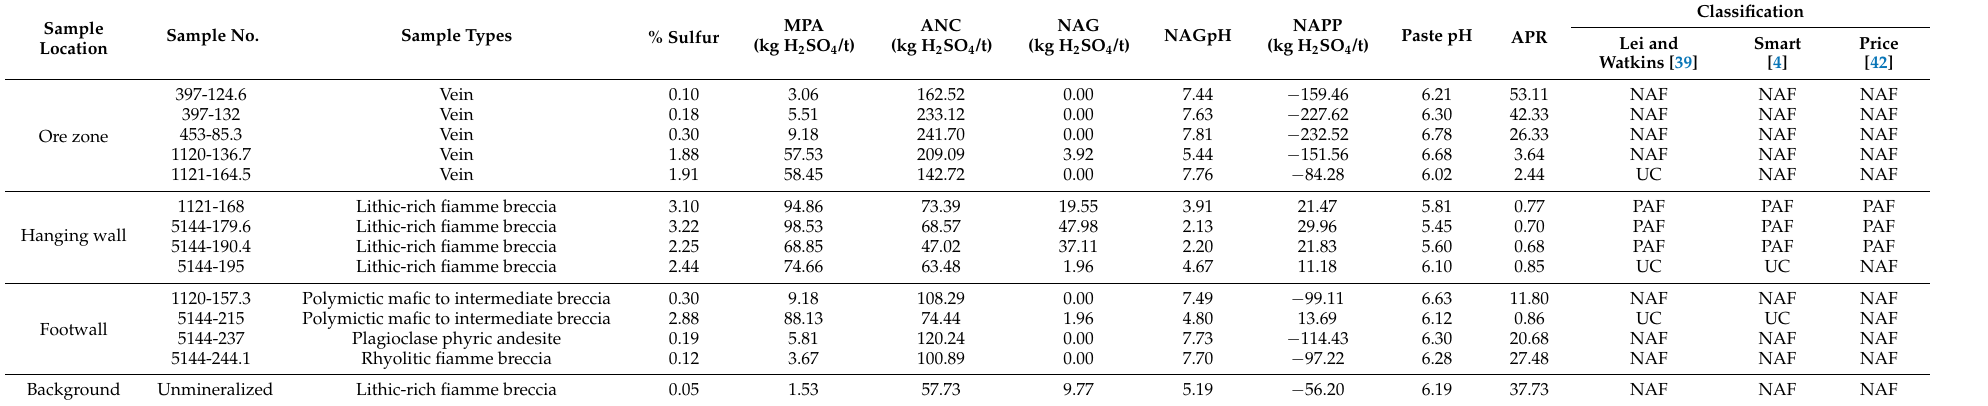
Table 3. Summary of the ABA and NAG test results of the representative samples from the H ore lens of the Chatree deposit. Sample Location